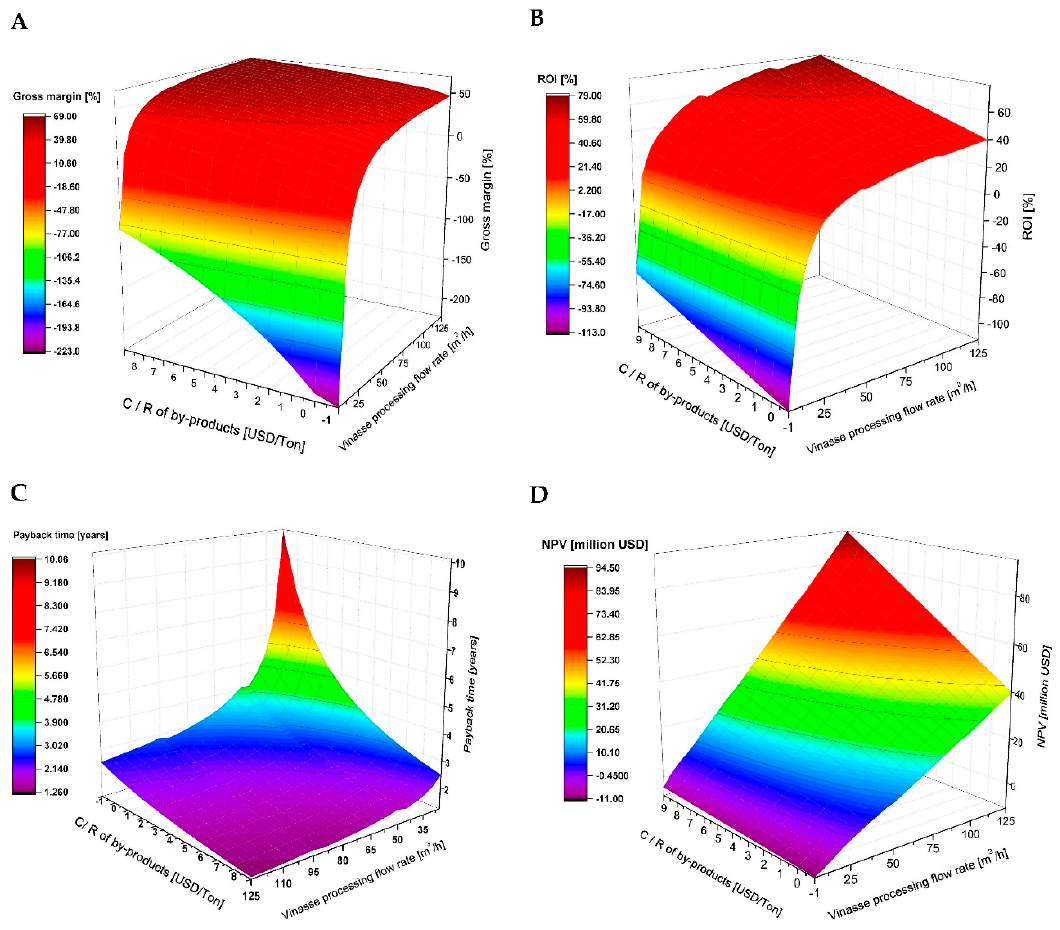
Figure 7. Economic assessment for the implementation of a vinasse-fed AD plant. ( A ) Gross margin, ( B ) return on investment (ROI), ( C ) payback time, and ( D ) net present value (NPV).